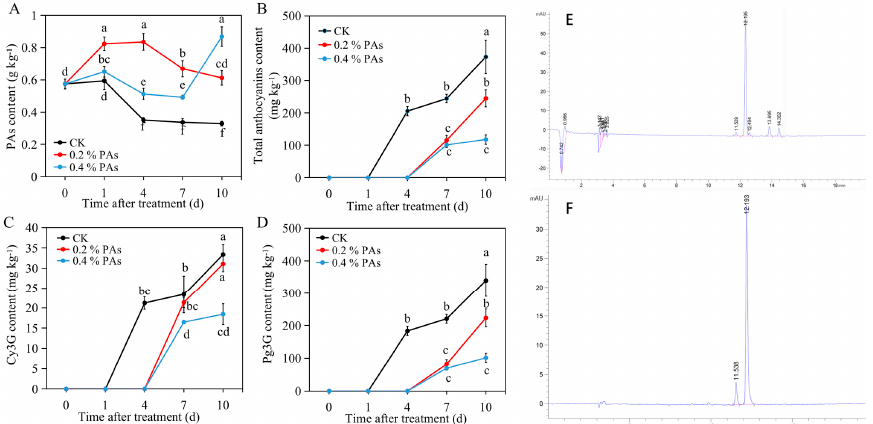
Figure 2. PA content and anthocyanin content in PA-treated and untreated fruit. ( A ) Change in PA content after the exogenous treatment. ( B ) Total anthocyanin content in the PA-treated and un- treated fruit. ( C , D ) Content of the main anthocyanin components, Cy3G (cyanidin 3-glucoside) and Pg3G (pelargonidin 3-glucoside), in the PA-treated fruit compared to the control. ( E ) HPLC peaks of 0.2% PA-treated sample at 7 d. ( F ) HPLC peaks of anthocyanins standards. The peaks with reten- tion time of around 11.5 and 12.2 min indicate the Cy3G and Pg3G, respectively. All data are pre- sented as mean value ± standard deviation. Mean values were obtained from three independent biological replicates. The lowercase letters indicate a significant difference based on LSD multiple test at p ≤ 0.05 level.